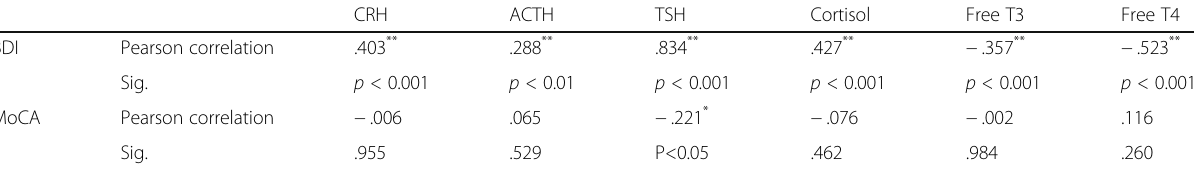
Table 5 Correlations between serum hormonal levels and BDI score, and MoCA score in patients with depression